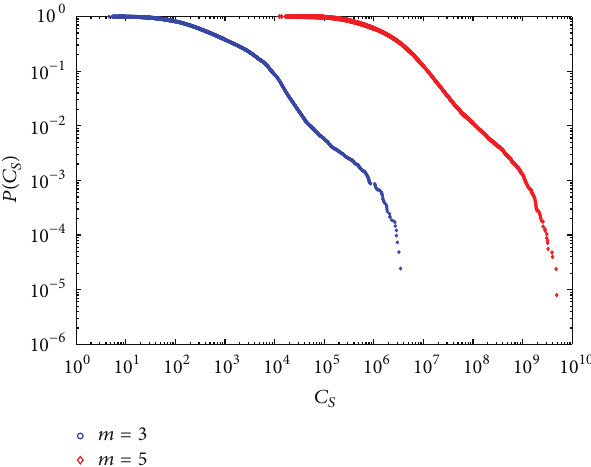
Figure 10: (Color online) Log-log plot of the cumulative distribu- tions of 𝑃(𝐶 𝑆 ) for the BA network model with 𝑚 = 3 (blue circles) and 𝑚 = 5 (red squares). All networks have 𝑁 = 2500